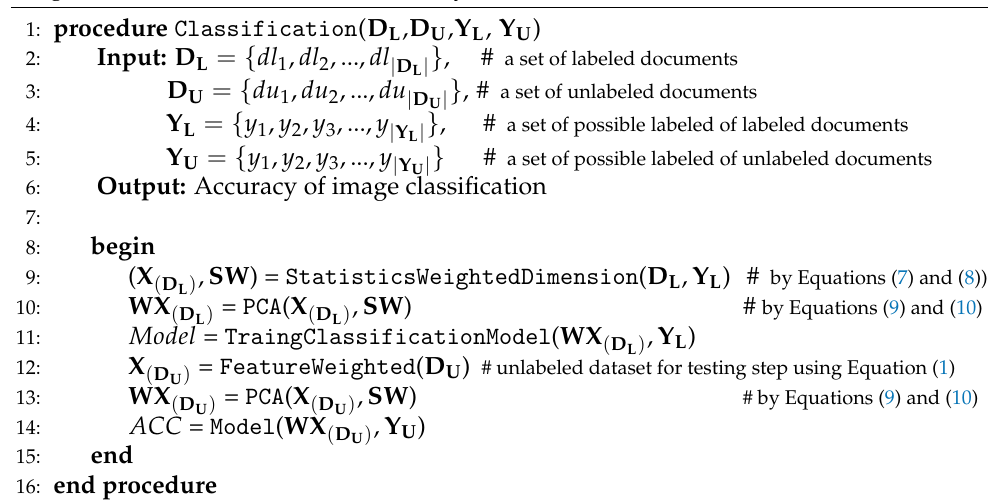
Algorithm 1 The main proposed pseudo-code of improving classification with statistically weighted dimensions and dimensionality